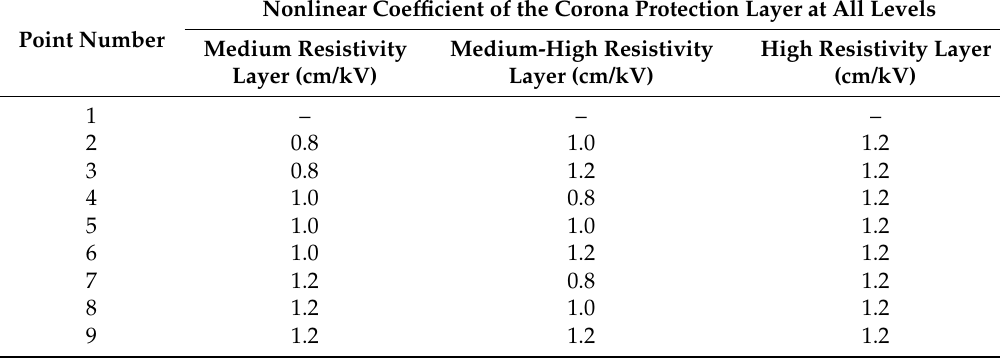
Table 3. Value of the nonlinear